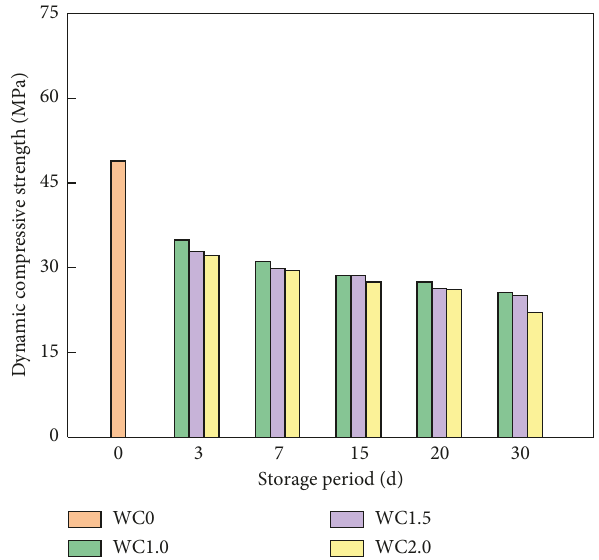
Figure 7: Dynamic compressive strength of ready-mixed concrete specimens with 0.9MPa impact pressure in uniaxial load